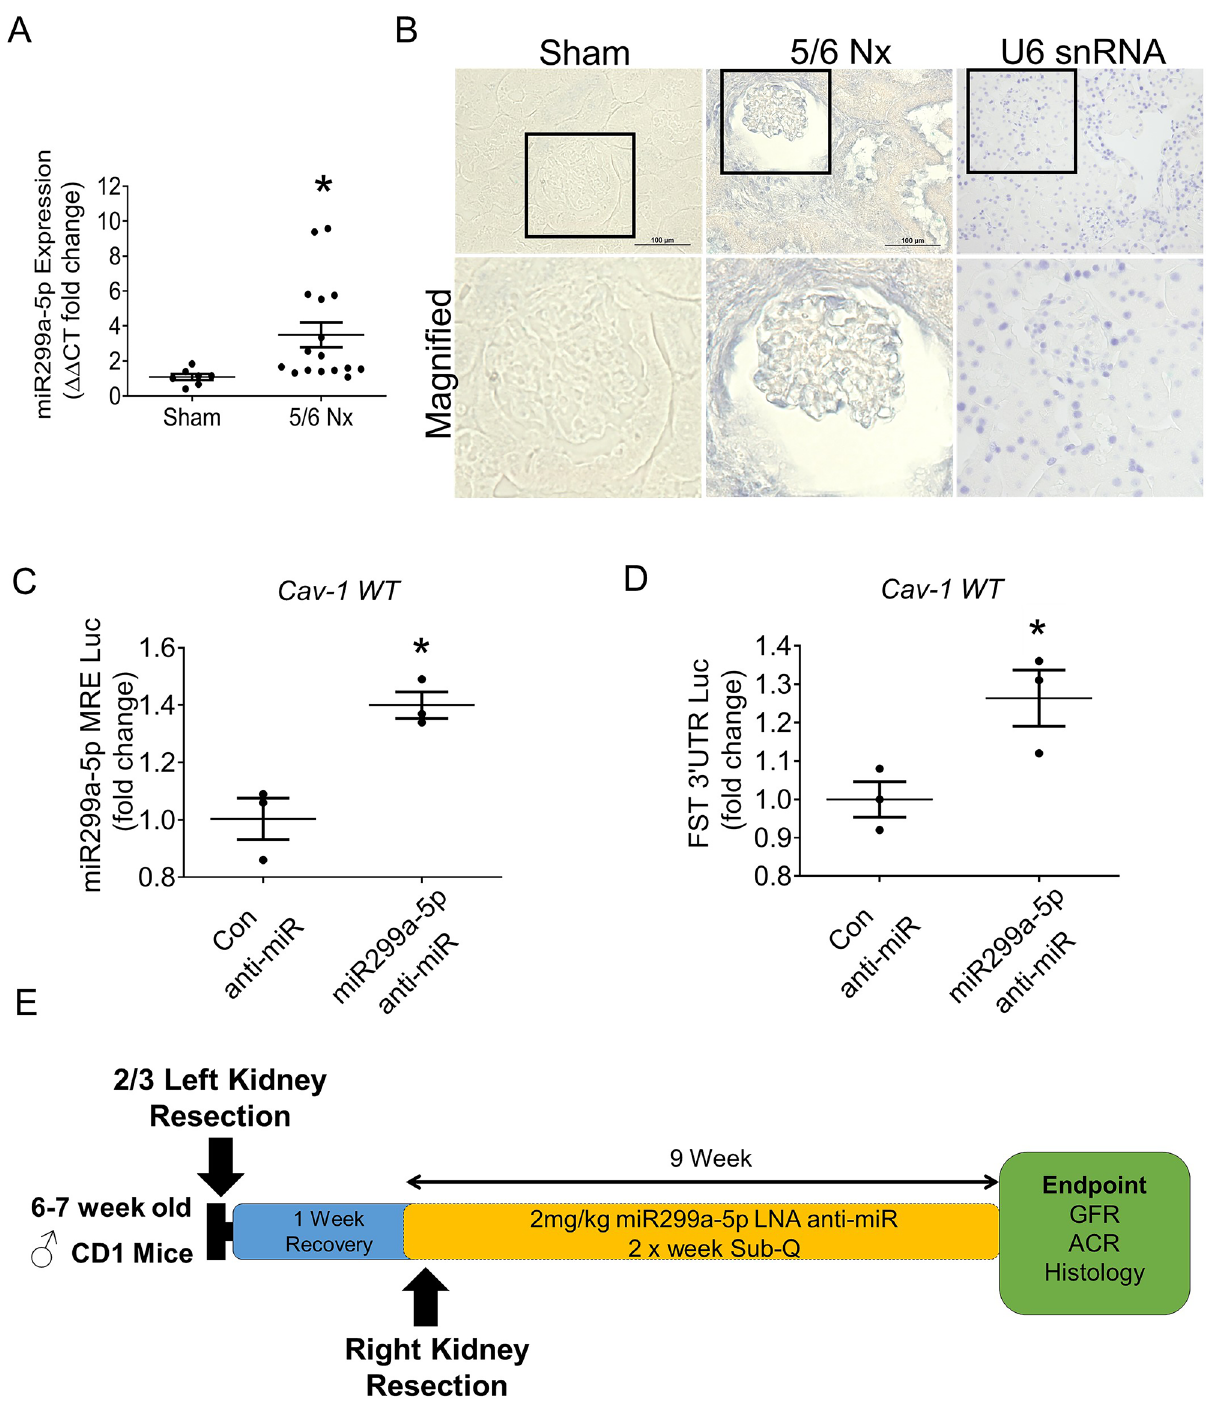
Figure 5. miR299a-5p expression is elevated in the kidneys of mice with CKD. The expression of miR299a-5p was strongly elevated in the glomeruli and tubules of mice with the 5/6 nephrectomy model of CKD, as assessed through qRT-PCR ( A ) and in-situ hybridization (ISH), where blue staining represents positive signal. U6 was used as a positive control. Staining in the absence of probe was also carried out as a negative control (images not shown). Magnified regions from the outlined boxes are shown to illustrate glomerular staining ( B ). ( C ) The in vivo miR299a-5p LNA anti-miR inhibitor (100 nM, 24 h) stabilized the MRE-luciferase in cav-1 WT MC (n = 3, *p < 0.05), as well as FST 3 ′ UTR luciferase construct ( D ) (n = 3, *p < 0.05). ( E ) Flowchart of the timeline for in vivo assessment of the anti-fibrotic potential of miR299a-5p inhibition using an in vivo LNA anti-miR inhibitor targeting miR299a-5p in mice with